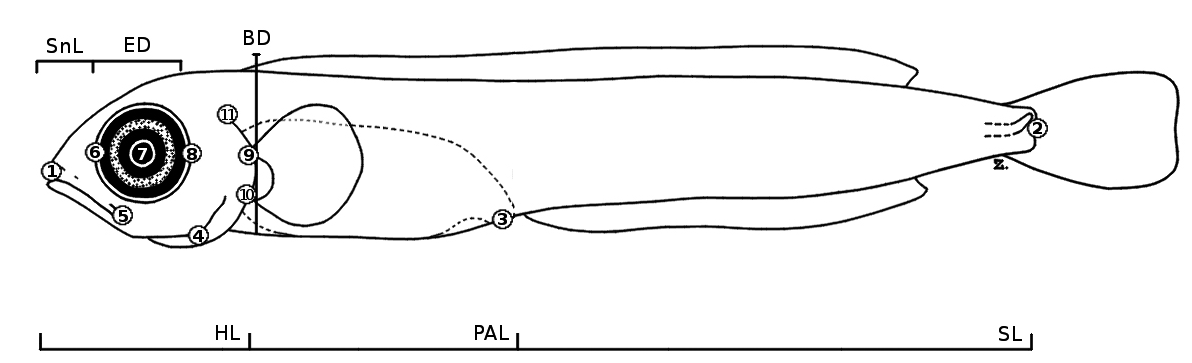
Fig. 1. – Measurements taken on the lateral aspect of each larvae and configuration of 13 landmarks used in the analysis of shape ontogeny of the kelpfish Myxodes viridis . Measurements: SL, standard length; PAL, preanal length; HL, head length; SnL, snout length; ED, eye diameter; BD, body depth. Landmarks: 1, snout tip; 2, posterior body extremity; 3, anus; 4, hindgut; 5, foregut loop; 6, cleithral symphysis; 7, angle of lower jaw; 8, centre of the eye; 9 hindbrain; 10, upper extreme of the eye; 11, lower extreme of the eye; 12, upper limit of the opercle; 13, anal position at the dorsal margin. Drawings by F.